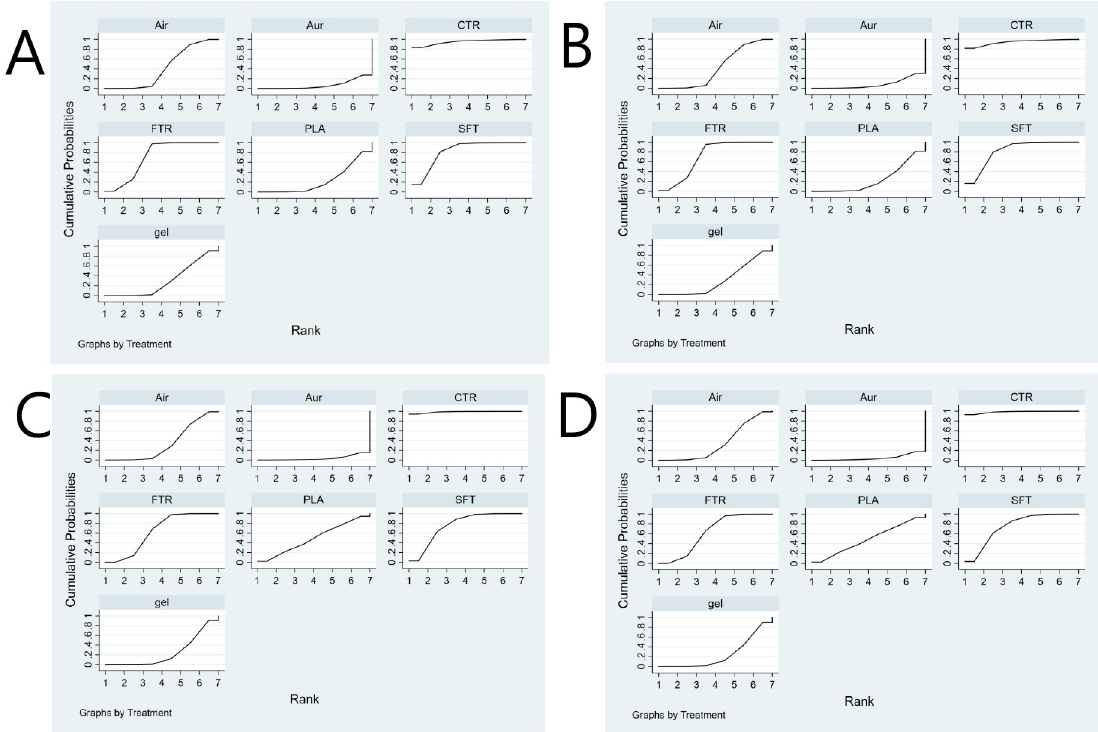
Fig 3. SUCRA probabilities. The SUCRA values of different supraglottic airway devices as a strategy for tracheal intubation. A. The overall success rate of unassisted tracheal intubation by ITT; B. The overall success rate of unassisted tracheal intubation by PP; C. The success rate at first attempt by ITT; D. The success rate at first attempt by PP. SUCRA, surface under the cumulative ranking curve; ITT, intention to treat; PP, per protocol. SFT = single-use LMA-Fastrach; PLA = CobraPLA; Air = Air-Q; FTR = LMA-Fastrach; gel = i-gel; Aur = Ambu-Aura; CTR =